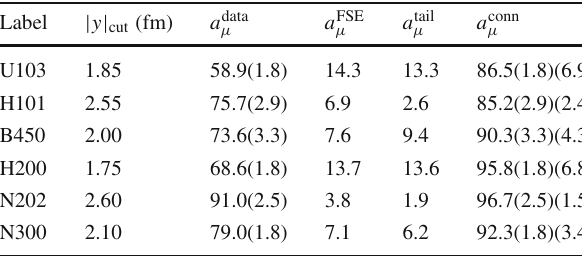
Table 6 Results for the connected contribution using method 2. Here a data μ corresponds to the value using lattice data up to some linearly- interpolated value of y = | y | cut , chosen to minimize the total error of a conn μ . Again, a 25% systematic to the total correction is used. In the last column we give the infinite-volume result